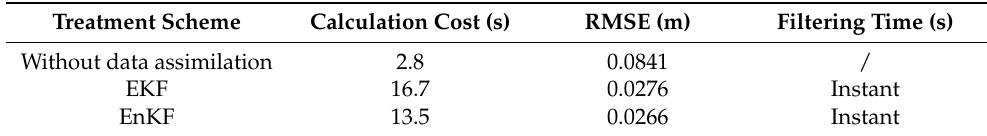
Figure 7. Water level simulation error values for different data treatment schemes. The black line represents the data that were not treated via data assimilation; the green line represents the data treated via EKF; the red line represents the data treated via EnKF. Table 7. Comparison of evaluation metrics for EKF and EnKF in Case 1.